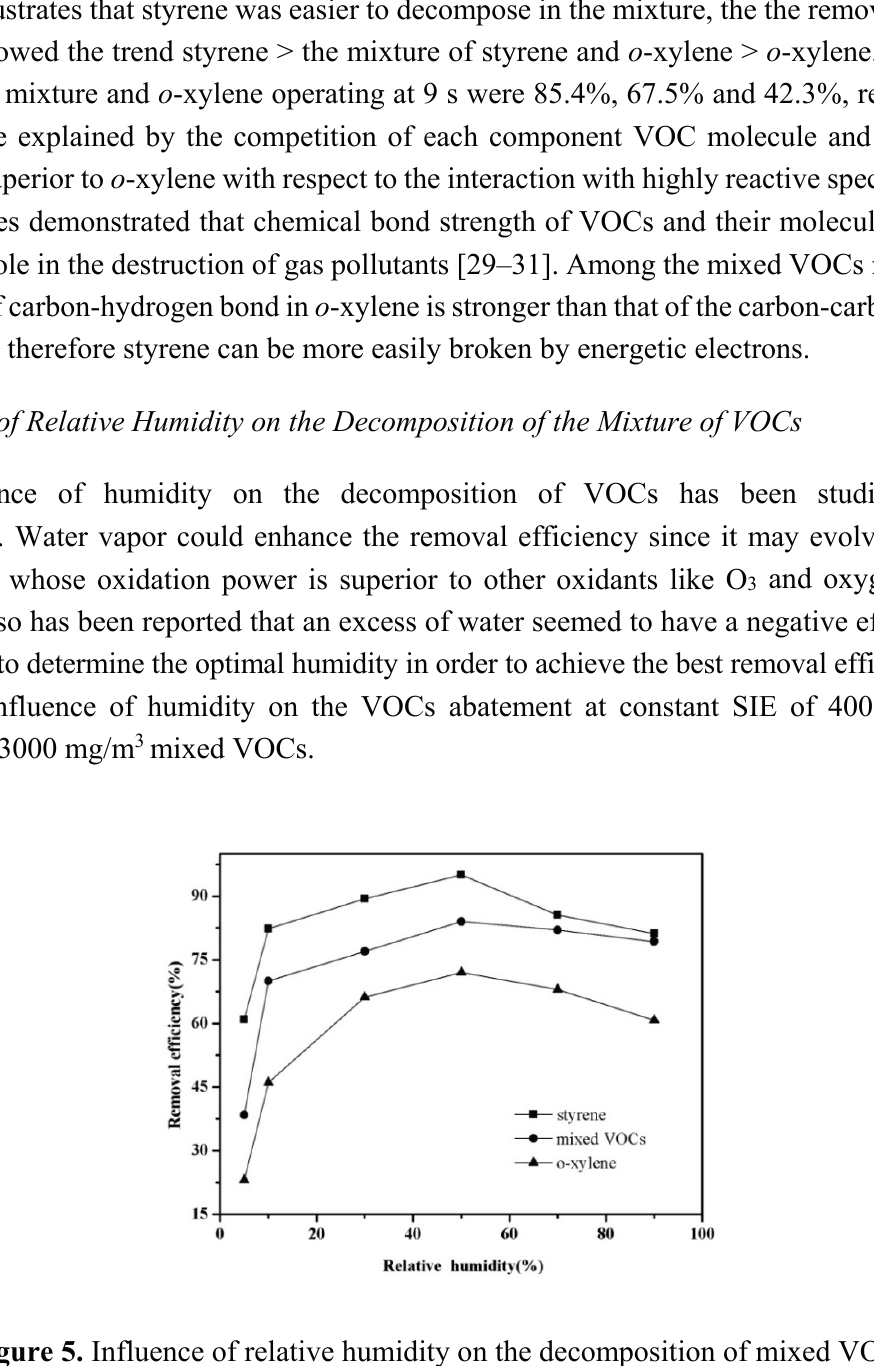
Figure 5. Influence of relative humidity on the decomposition of mixed